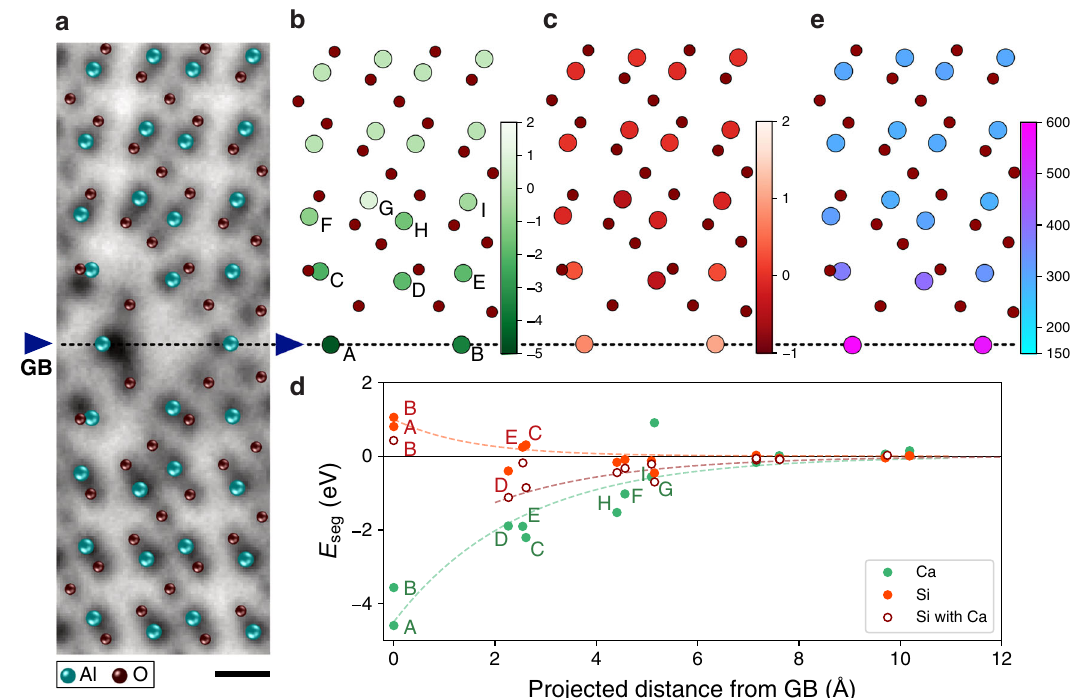
Fig. 2 | The segregation energies of dopants in pristine Σ 13 M(Al) GB. a The relaxed atomic structure model overlaid on ABF-STEM image viewed along the ½ 11 (cid:1) 20 (cid:2) axis,whereAlandOatomsarerepresentedbythecolorsofcyananddark red,respectively.ThearrowheadscorrespondtothecenteroftheGBcore.The dashed line indicates the GB position. The scale bar is 2Å. The segregation energies of b Ca and c Si atoms at respective atomic sites in the pristine Σ 13